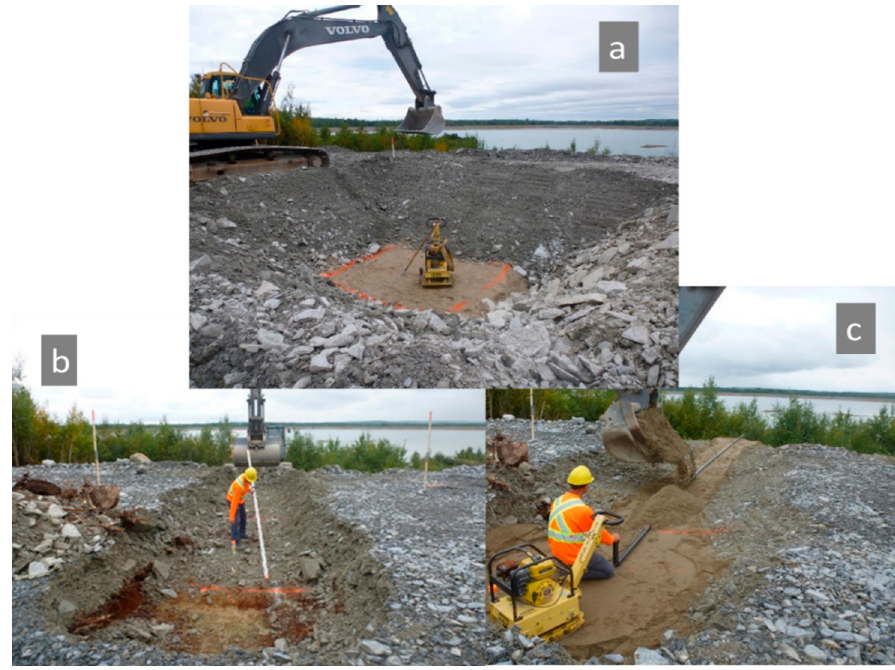
Figure 2. ( a ) Inverted truncated pyramid form of the experimental cell, ( b ) excavation of the trench, and ( c ) installation of the PVC pipe for the drainage